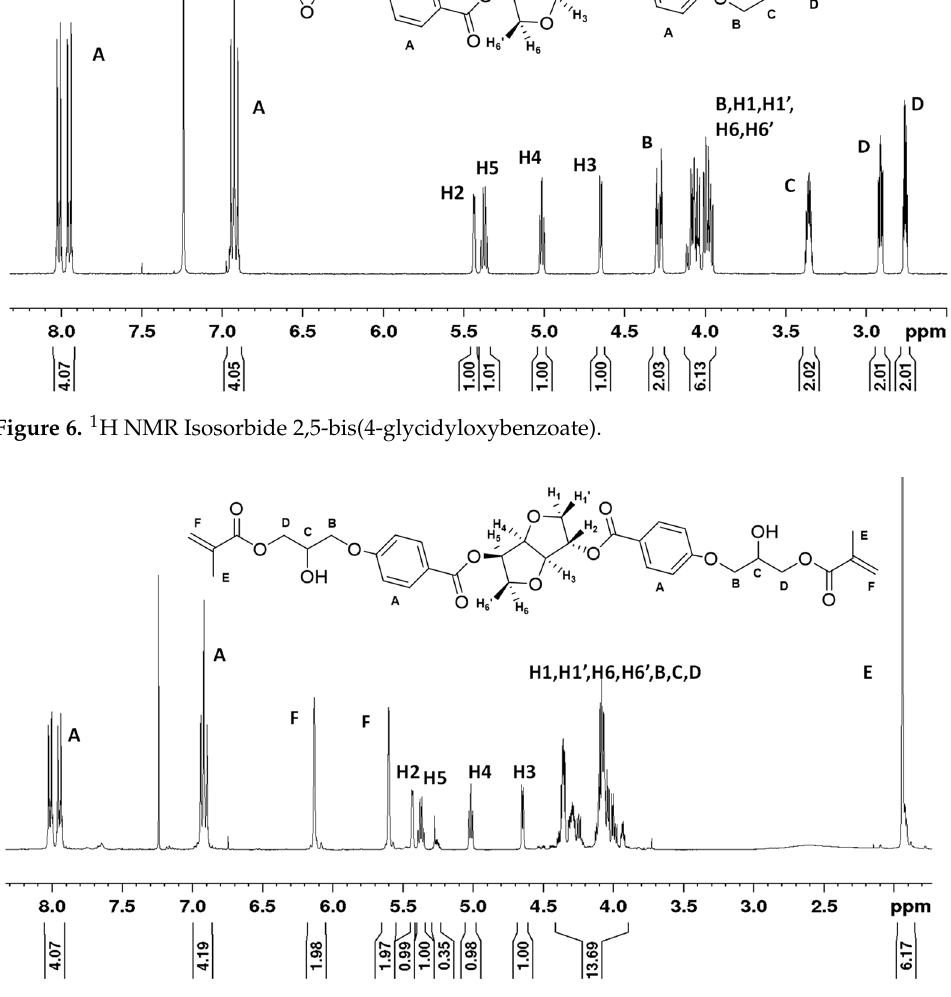
Figure 8. 1 H Isosorbide 2,5-bis(glyceryloxy) dimethacrylate. The benzoate functionality in ISBGBMA monomers was added to increase the hy- drophobicity over ISDGMA. Contact angle measurements and cLogP estimations of ISBGBMA monomers, ISDGMA, and BisGMA are reported in Table 1. The mean contact angle ( θ ) of ISBGBMA monomers at (~62.9°) is higher than 13.41° for ISDGMA. This indi- cates that the new monomers are more hydrophobic [41]. However, they are less hydro- phobic than BisGMA at 77°. The cLogP estimations indicate the ISBGBMA monomers to be more hydrophobic than ISDGMA, but less hydrophobic than BisGMA as well [42].